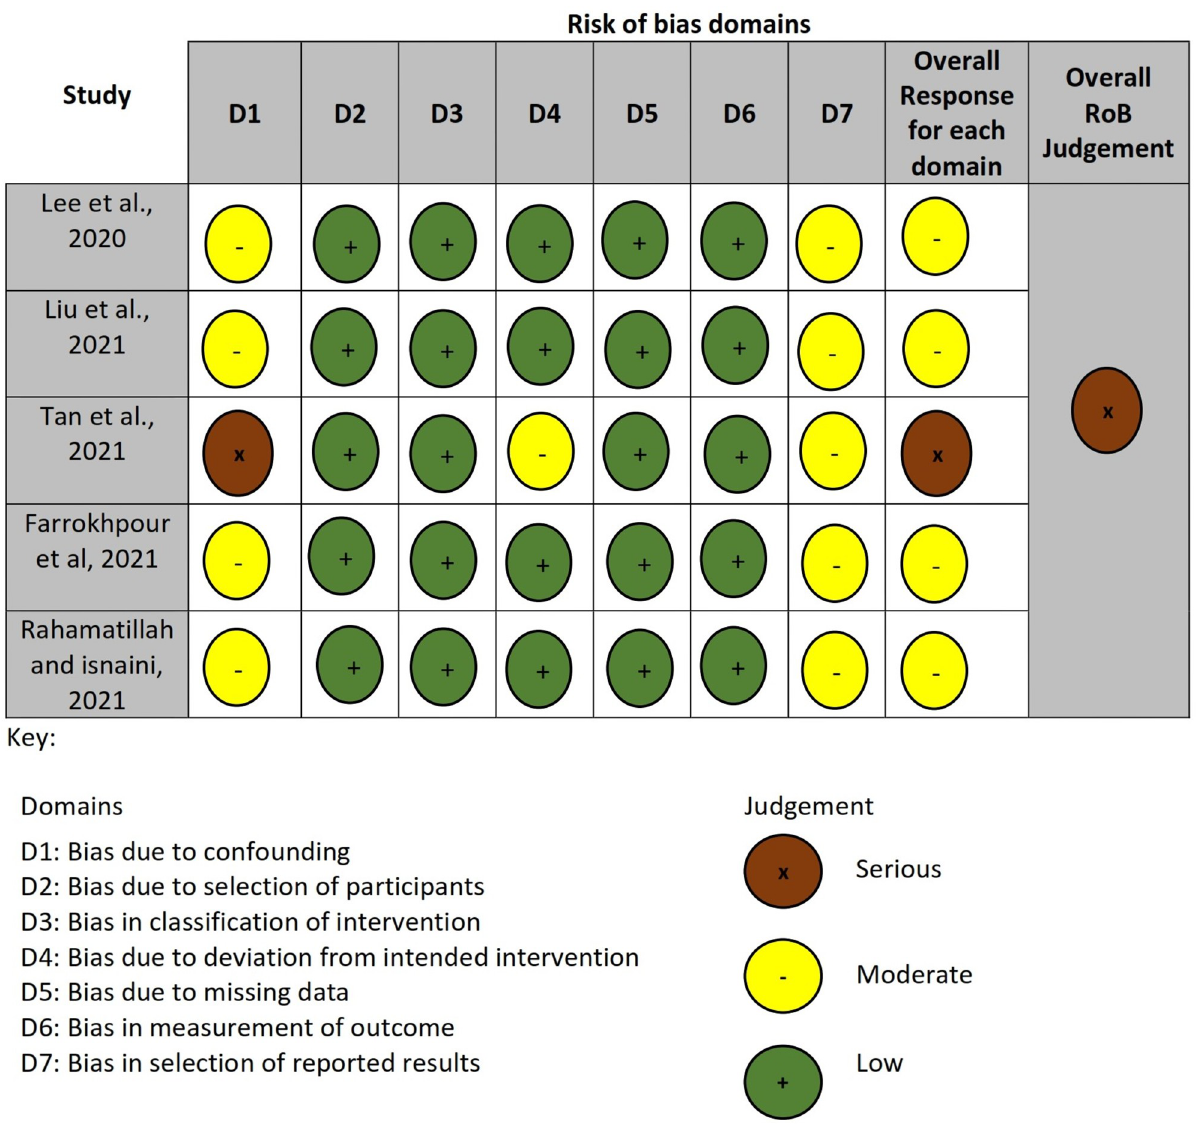
Fig 2. Summary for the ROBINS-I tool. Shows RoB assessment for primary outcome